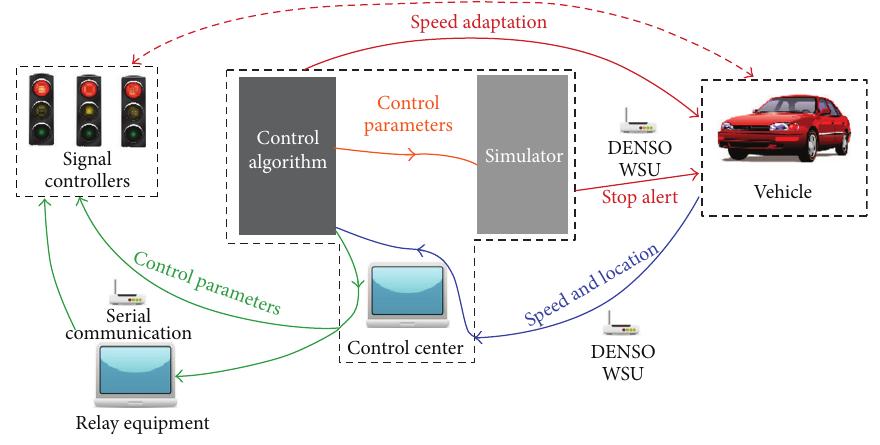
Figure 4: HIL simulator framework.